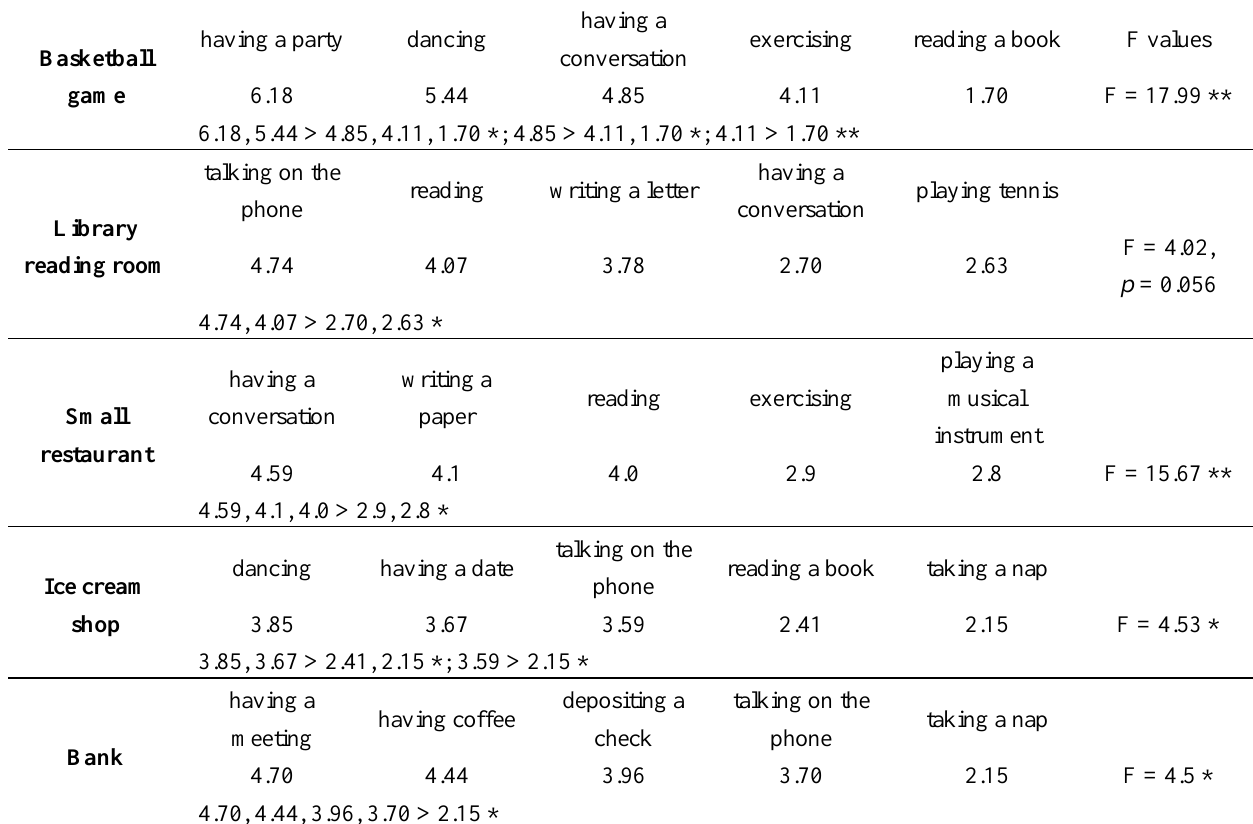
Table 6. Mean ratings of appropriateness (1–7) for each activity following the viewing of each setting